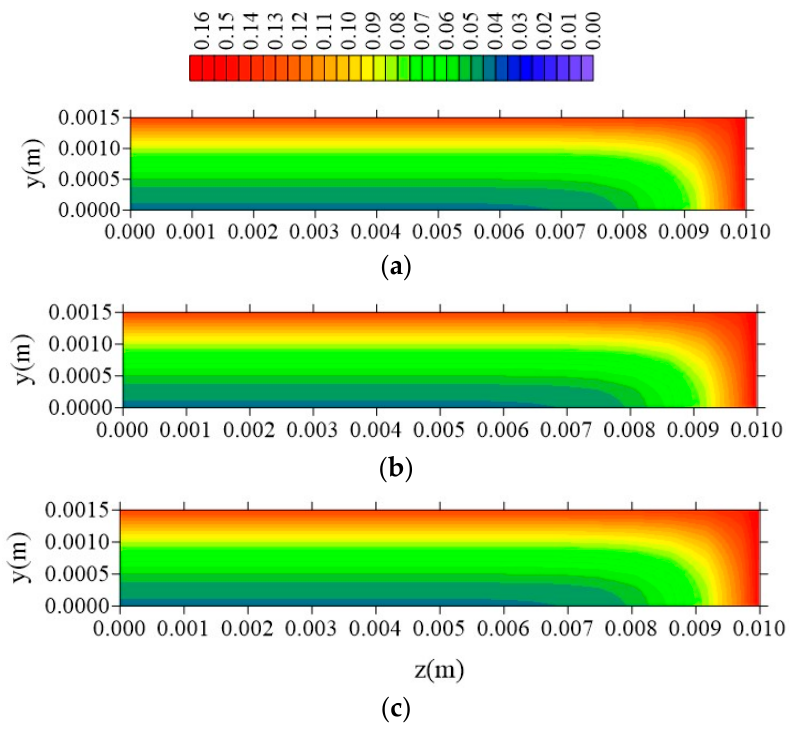
Figure 15. Distribution of free solute concentration (C in kg/kg) in plan x = R x /2 for different distances l x (t = 211 h, Cases 8, 9, and 10). In which ( a ) l x = 0.01m; l y = 0.01 m and l z = 0.1 m; ( b ) l x = 0.1 m; l y = 0.01 m and l z = 0.1 m; ( c ) l x = 1 m; l y = 0.01 m and l z = 0.1 m.